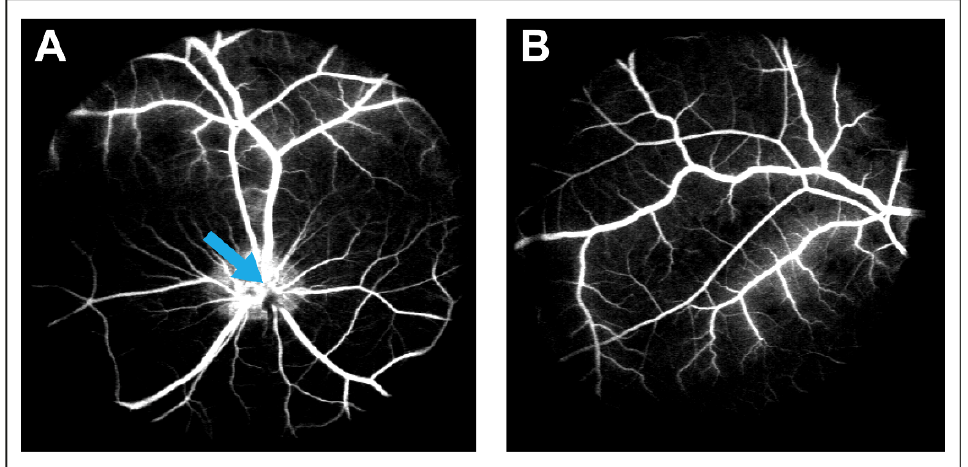
Figure 2. Fluorescein angiography performed four days after CRVO was induced. ( A ) Delayed venous filling and leakage can be observed in the CRVO model. Blue arrow: Site of occlusion. ( B ) Leakage in the peripheral retina observed on angiography following CRVO.